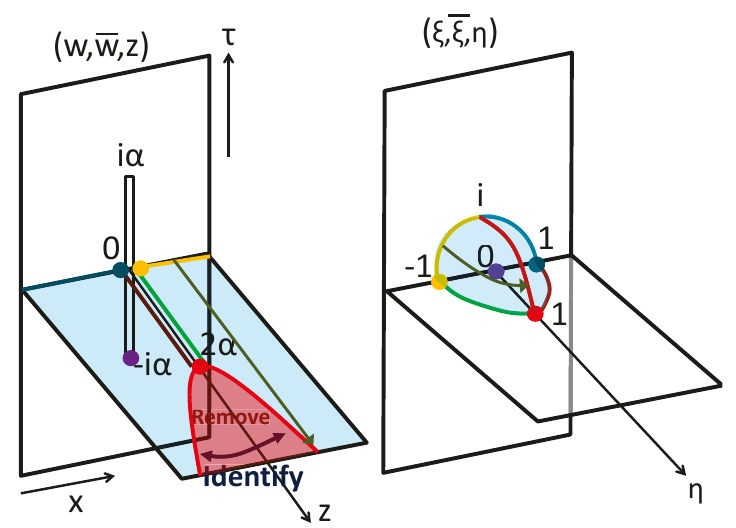
and the region inside this (cid:11)